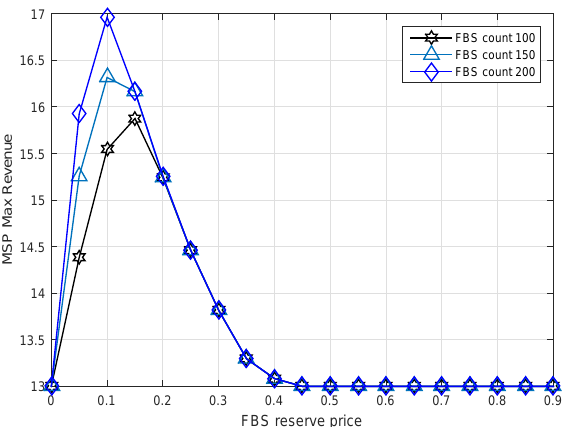
Figure 11. Max revenue of MSP versus FBS reserve price under different FBS counts.